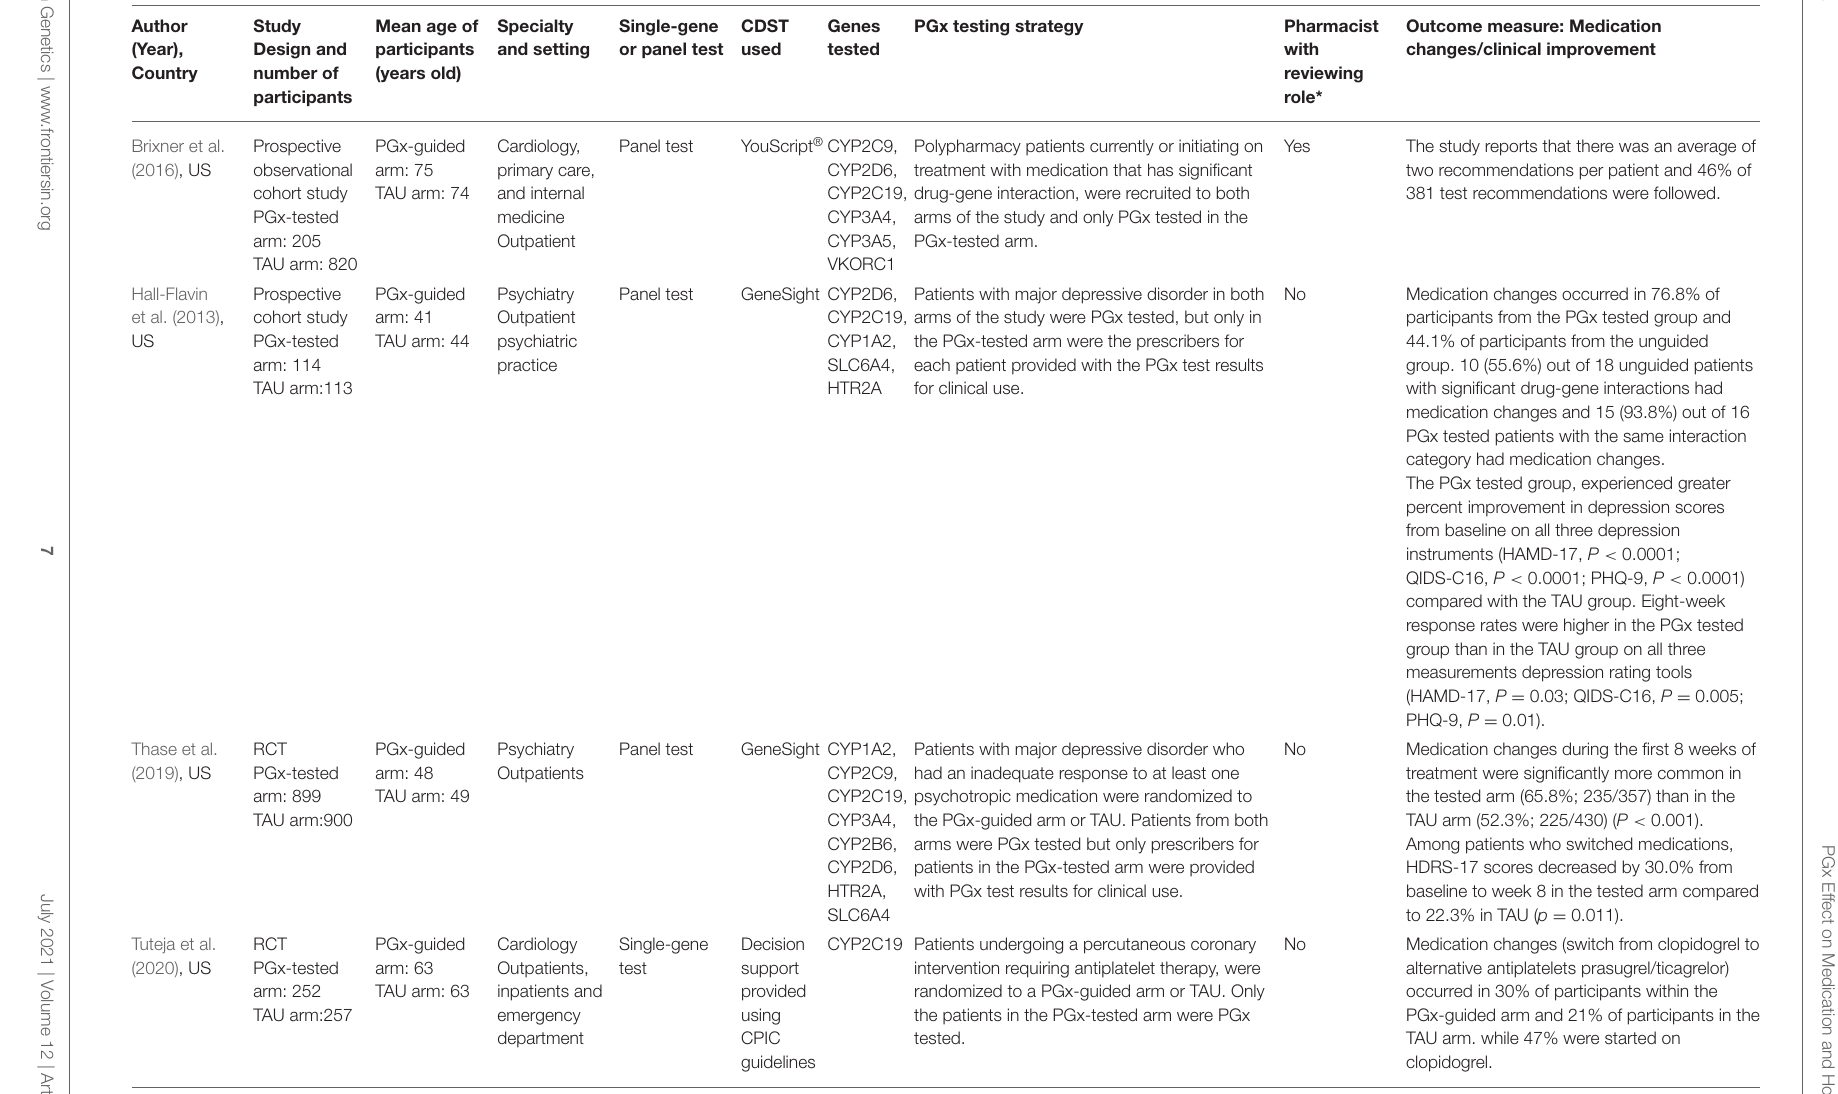
TABLE 3 | Summary of study characteristics for medication change